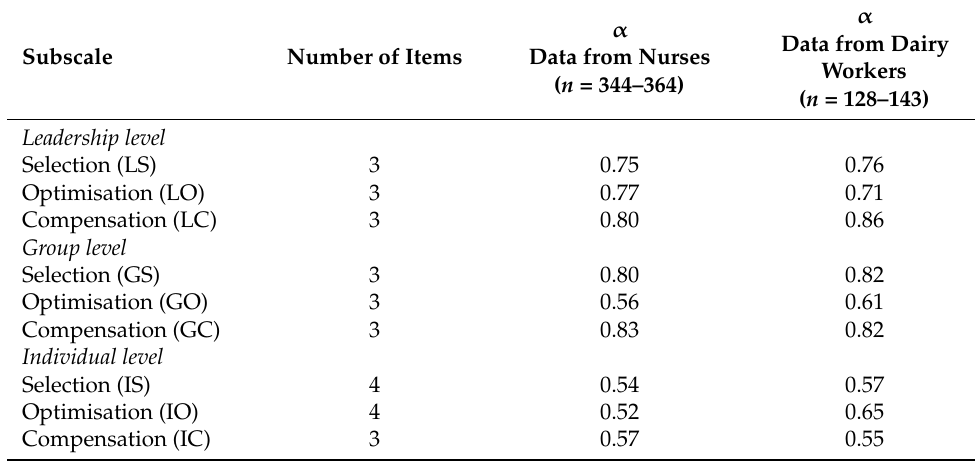
Table 3. Cronbach’s alpha for the subscales in the questionnaire.